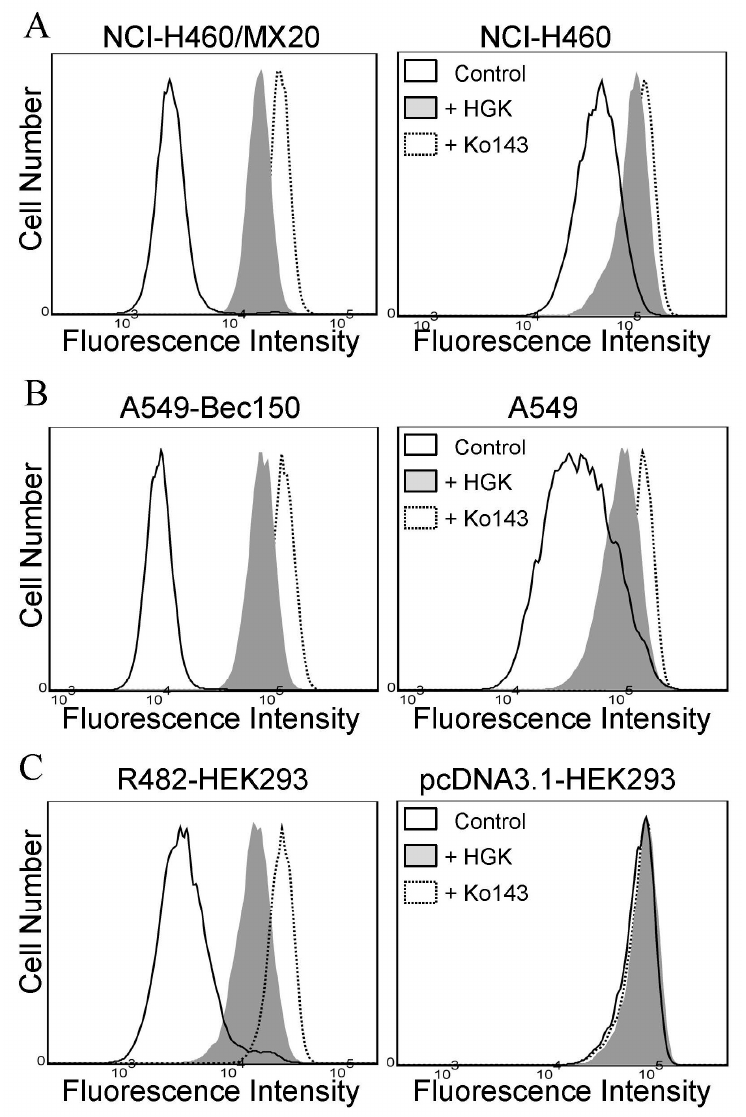
Figure 4. Hydroxygenkwanin attenuates ABCG2-mediated fluorescent substrate transport. The intracellular accumulation of a known fluorescent substrate, pheophorbide A (PhA), was determined in ( A ) NCI-H460 and NCI-H460/MX20 cancer cell lines, ( B ) A549 and A549-Bec150 cancer cell lines, and ( C ) pcDNA3.1-HEK293 and R482-HEK293 cell lines, in the presence of DMSO (control, solid line), 1 µ M hydroxygenkwanin (+HGK, gray-shaded solid line), or 5 µ M Ko143 (+Ko143, dotted line), which was used as a positive control for ABCG2. The fluorescent signals were analyzed with flow cytometry, as described in the Section 4. Histograms are representative results from at least three independent experiments.